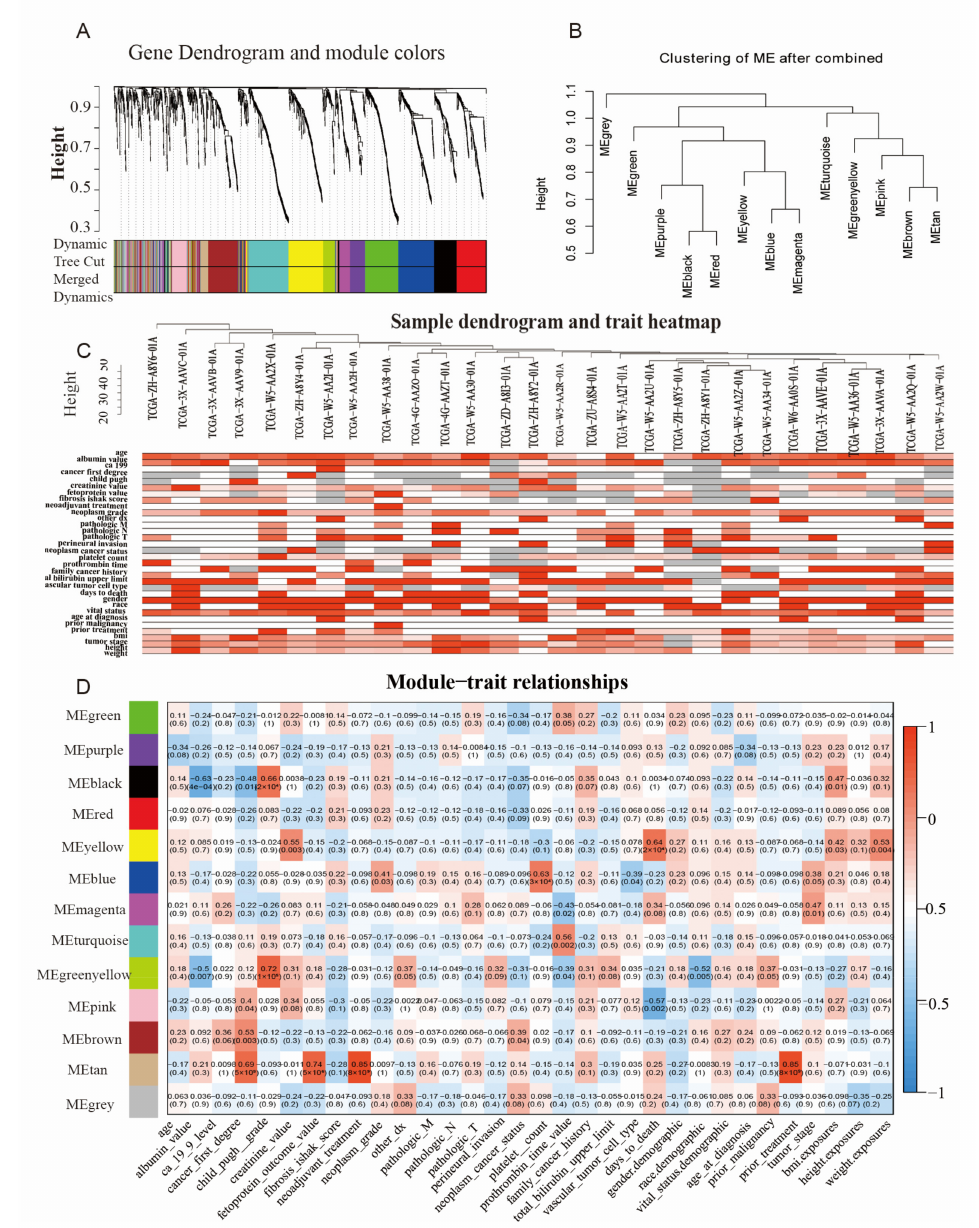
Figure 4. Construction of WGCNA network. ( A ) Dendrogram of gene topological matrix branch (MEs with similarity > 0.75 were merged). ( B ) Dendrogram and heatmap of 13 eigengenes. Dynamic tree of the merged MEs with similarity greater than 0.75. ( C ) Clinical modules were clustered, and correlations were investigated with a sample dendrogram. The color of the heat indicated the correlation value. With respect to clinical data, red represents a high value, white means a low value, and gray means a missing value. ( D ) Heatmap of correlations between MEs and clinical features of CCA. The correlation coefficient (cor) and corresponding p -value ( p -value) between different gene modules and clinical traits. According to the size of correlation coefficient (cor), the darker red represents positive correlation, and the darker blue represents negative